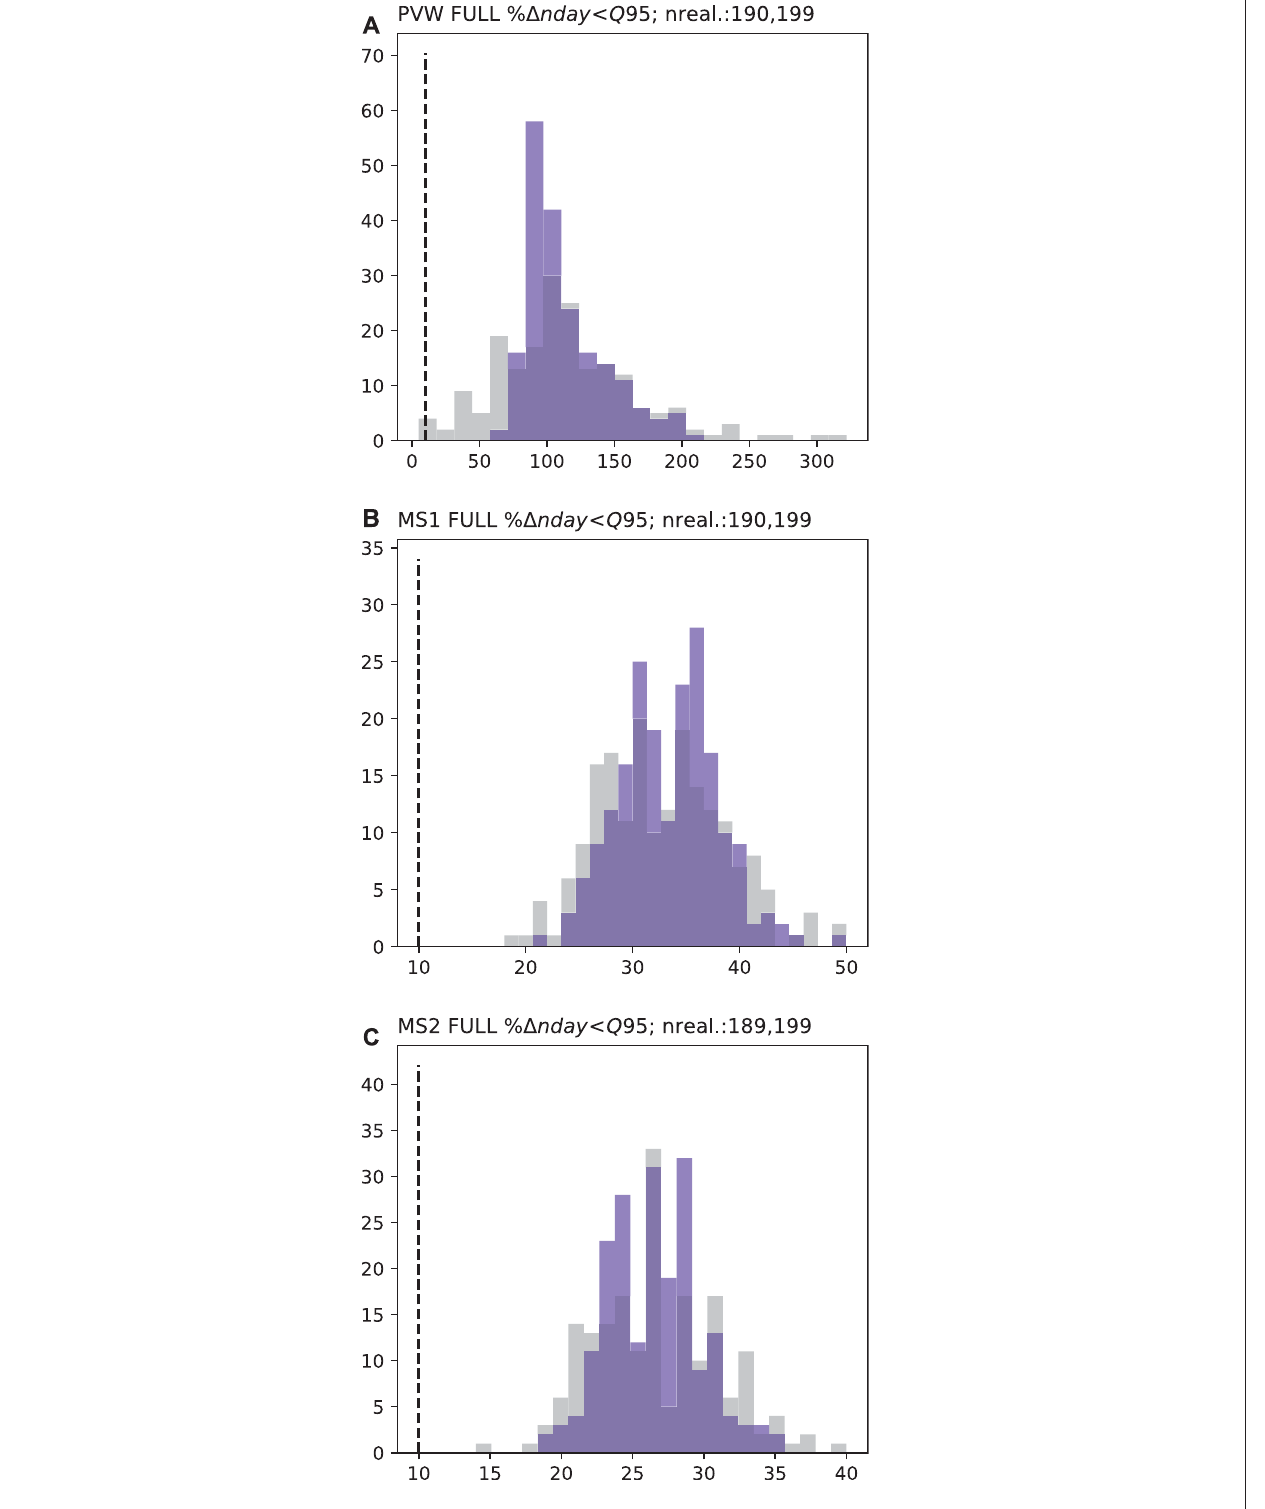
FIGURE5| Percentchangelow- fl owfrequency( %nday < Q95 )prior(grey)andposterior(blue)forecastPDFsatPWV (A) ,MS1 (B) andMS2 (C) .Dashedblacklines representsthe10%changedecisionthreshold. “ nreal. ” detailsthenumberofsuccessfulrealizations(thereforethenumberofdatapointsrepresentedinthePDF)forprior and posterior ensembles, respectively.